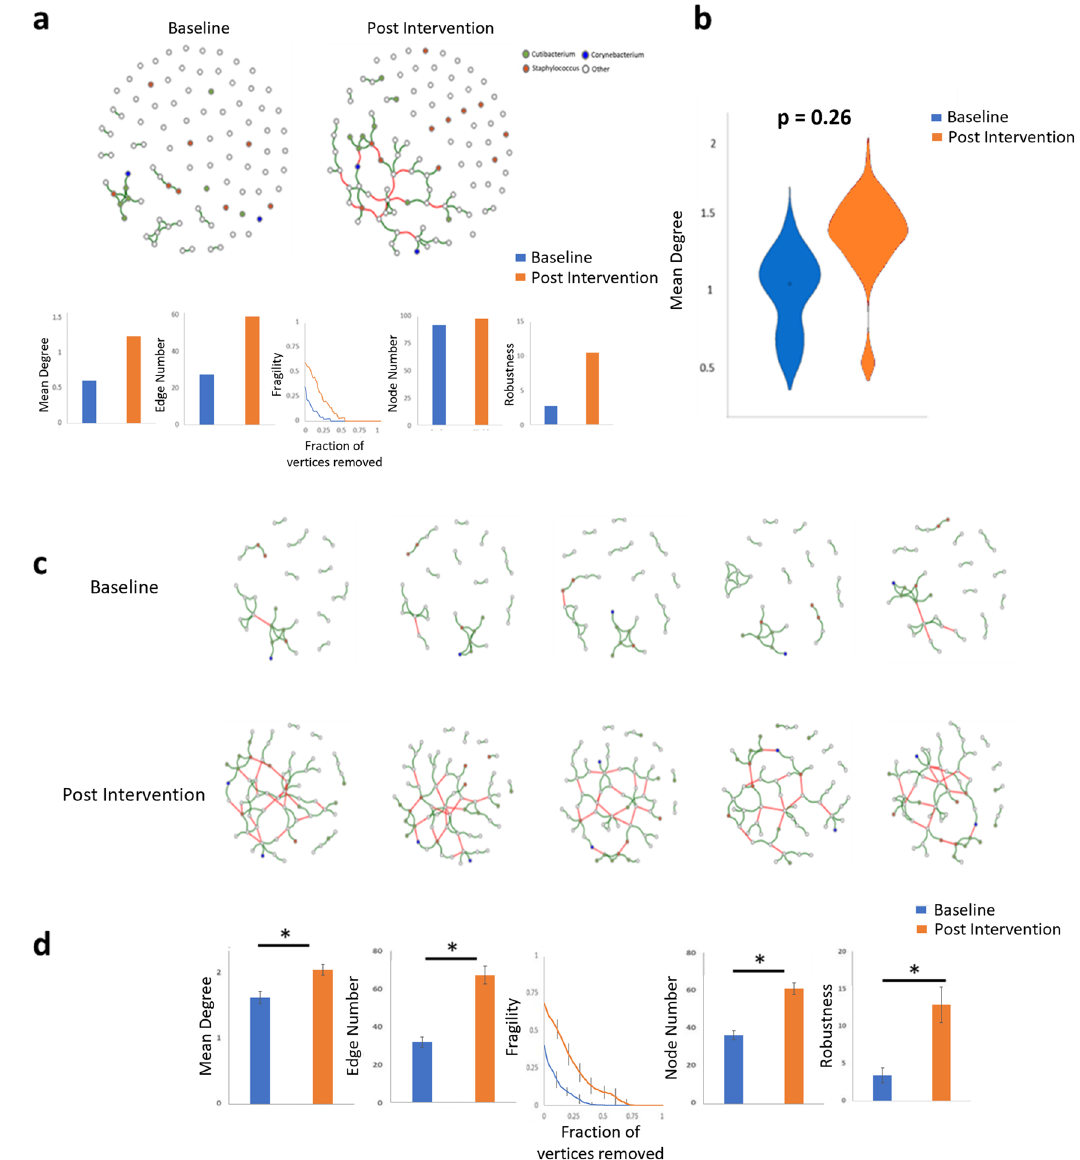
Figure 4. Community co-occurrence network analysis. ( a ) Average community networks for all samples at baseline and following 5 weeks of application, with associated network metrics. ( b ) Example statistical analysis of network mean degree metric following bootstrapping between samples at baseline and post intervention. No metrics used showed differences between pre- and post-application using average network approaches. ( c ) Selected indicative examples of single sample network from individual subject at baseline and post intervention. ( d ) Network analysis metrics between networks at baseline and post